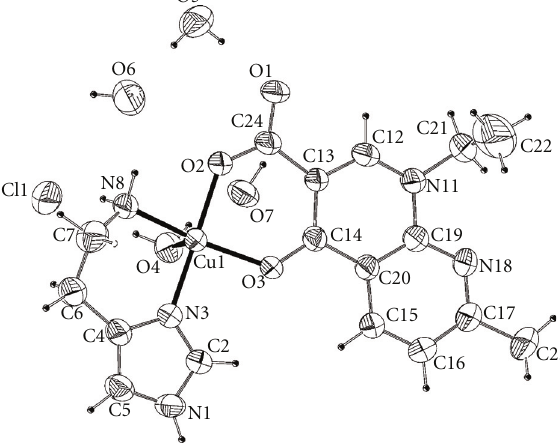
Figure 2: ORTEP plot showing the molecular structure of [Cu(hsm)(nal)H 2 O]Cl · 3H 2 O complex. Ellipsoids are at 50%